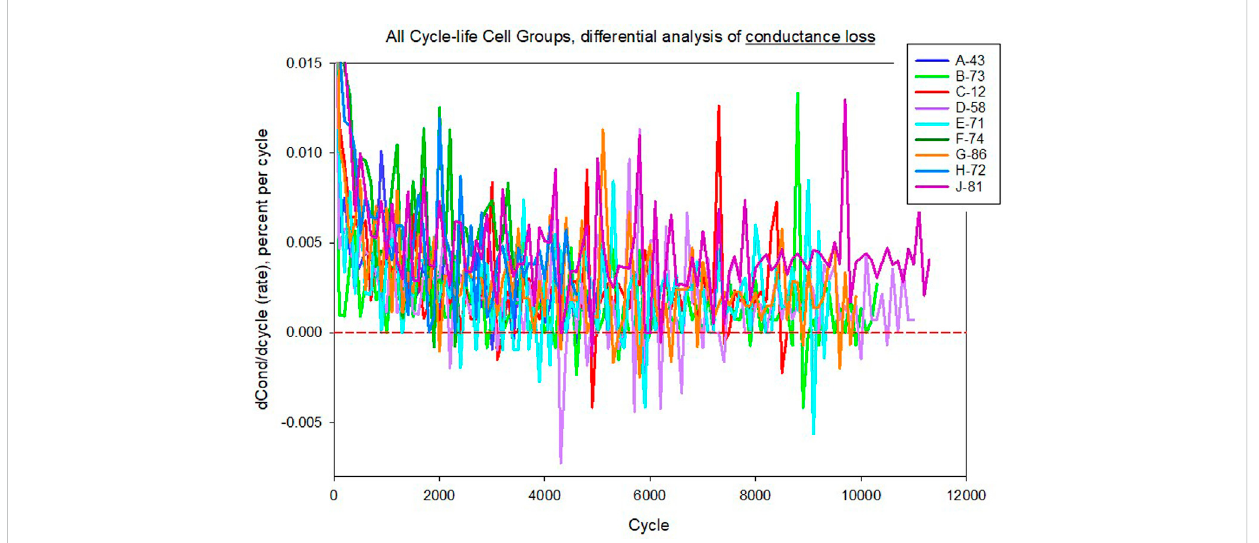
Differential rate analysis of conductance loss for representative LMO/LTO cells tested under nine different cycle-life conditions. Data variance per cell is relatively high compared to capacity loss data (same scales used as in Figure 10). Some of the noise appears random, with many points in the negative rate